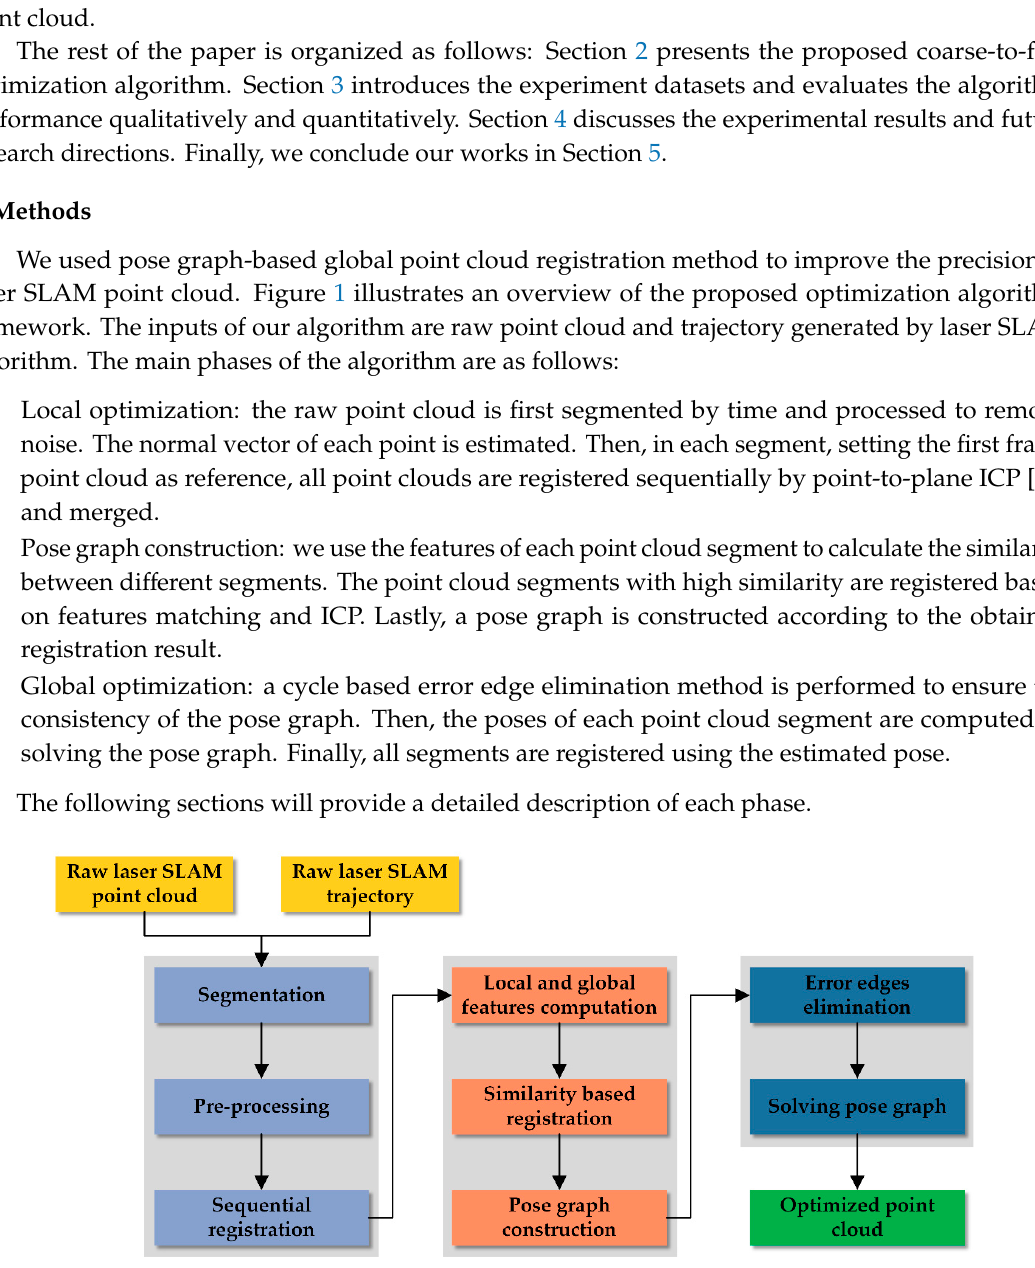
Figure 1. Overview of the proposed laser simultaneous localization and mapping (SLAM) point cloud optimization